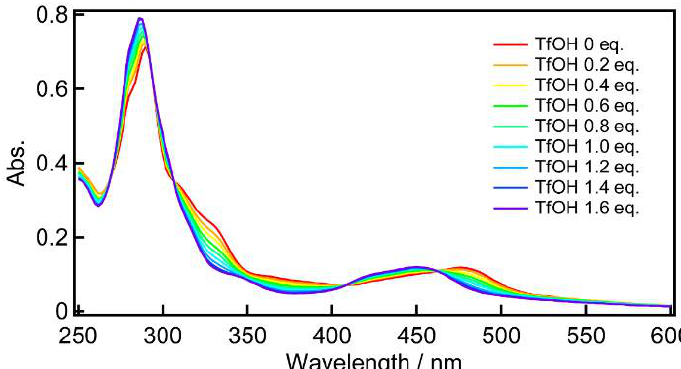
Figure 4. UV-Vis absorption spectral changes of complex 1 with TfOH.